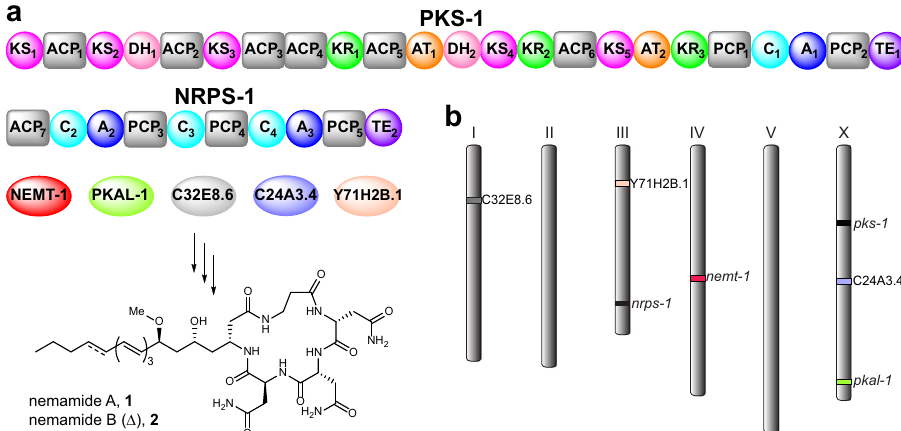
Fig. 1 Enzymes required for nemamide biosynthesis. a The domain organization of PKS-1 and NRPS-1 is shown, along with fi ve additional free-standing enzymes (NEMT-1, PKAL-1, C32E8.6, C24A3.4, and Y71H2B.1) that were demonstrated in this study to be required for nemamide biosynthesis. To facilitate annotation of the mutant worm strains generated in this study, the enzyme domains have been numbered according to the order of their appearance in PKS-1 and NRPS-1. The ACP 7 domain was identi fi ed and its functional role was con fi rmed in this study. Domain abbreviations: acyl carrier protein (ACP), acyltransferase (AT), ketosynthase (KS), ketoreductase (KR), dehydratase (DH), peptidyl carrier protein (PCP), adenylation (A), condensation (C), thioesterase (TE). b The approximate chromosomal location in C. elegans of pks-1 , nrps-1 , and the fi ve additional genes demonstrated to be required for nemamide biosynthesis in this